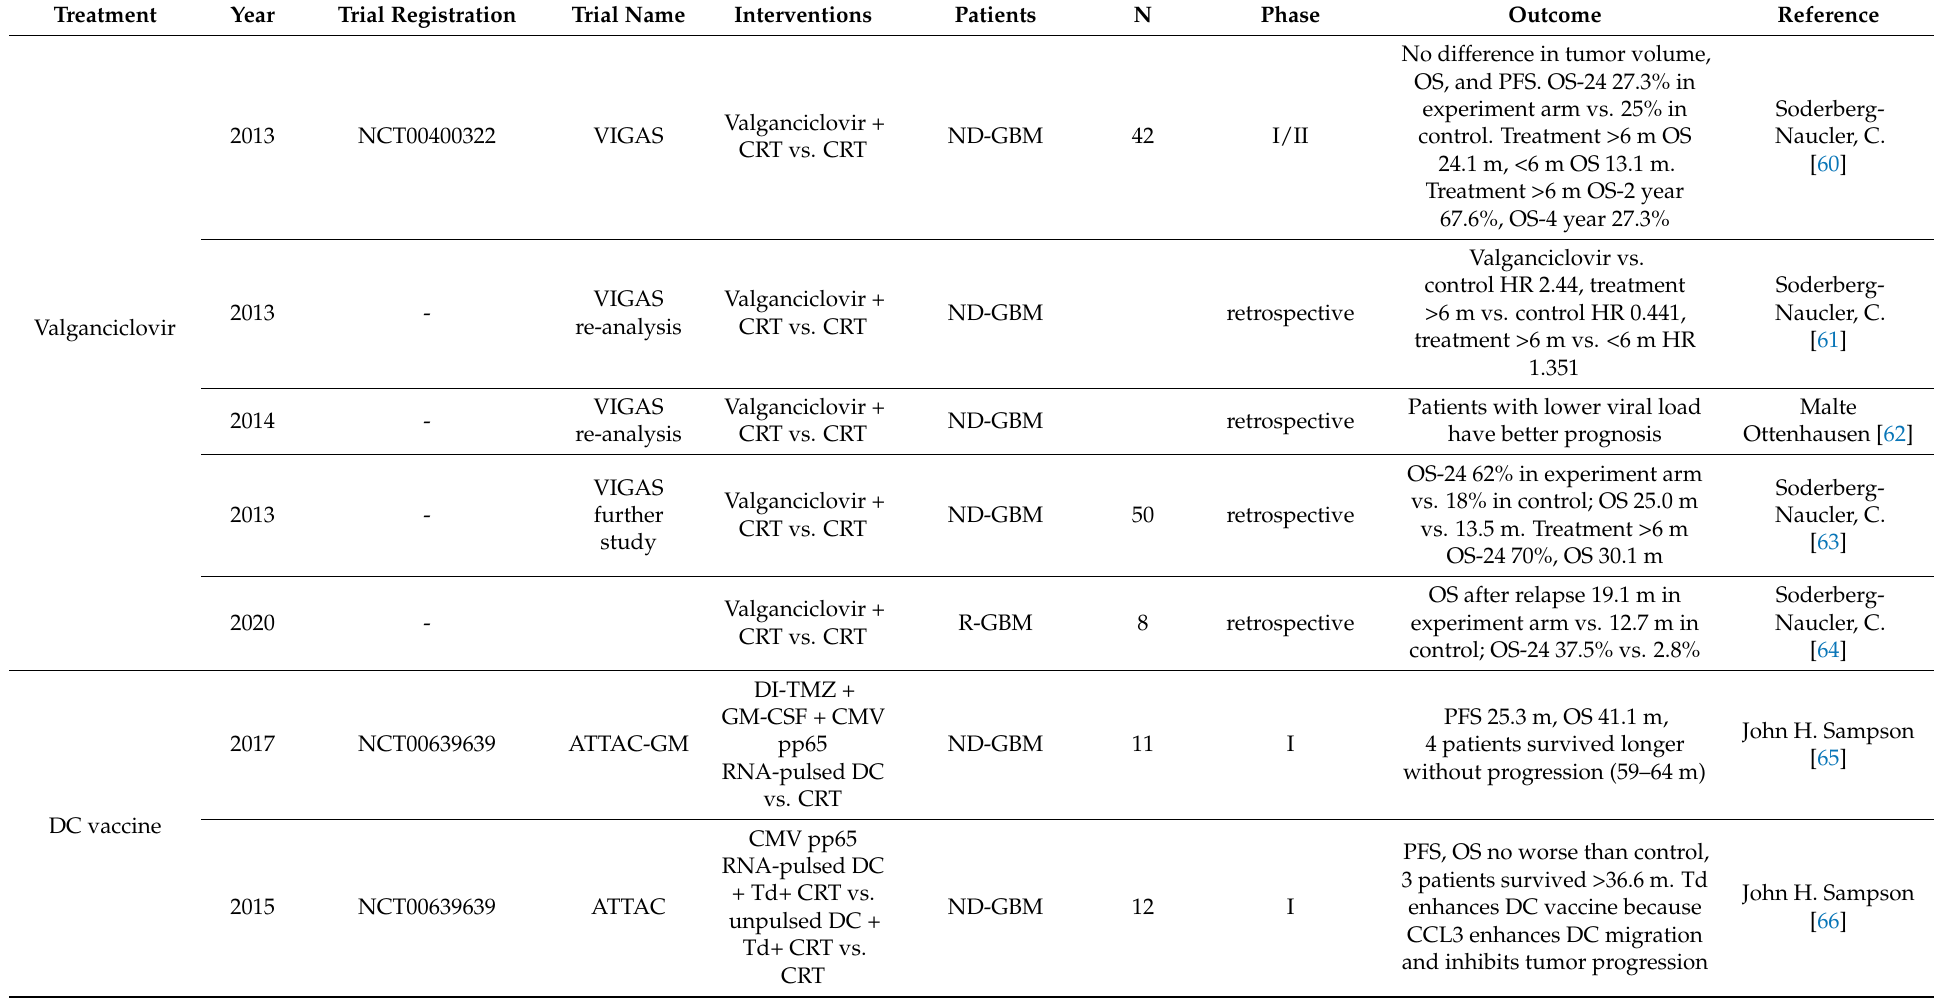
Table 1. CMV-related clinical studies to treat GBM, with published